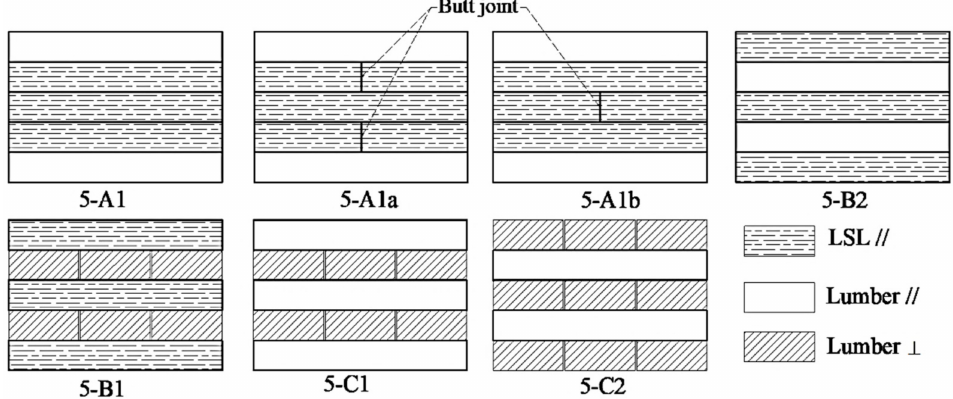
Figure 1. Cross sections of five-layer CLP and CLT in the length direction with different layups.